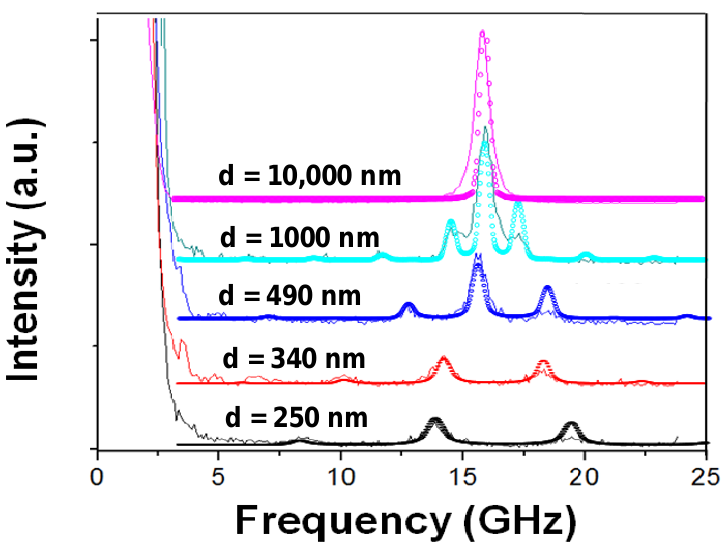
Figure 3. Theoretical spectra (open circles) evaluated using the approximate expression (Equation (25)) for the same thicknesses of PMMA film on Si substrate. Solid curves correspond to experiments.